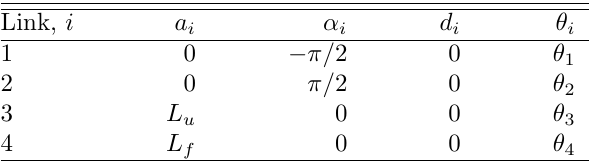
Table 1: Denavit-Hartenberg parameters of the UB- AXO Link, i